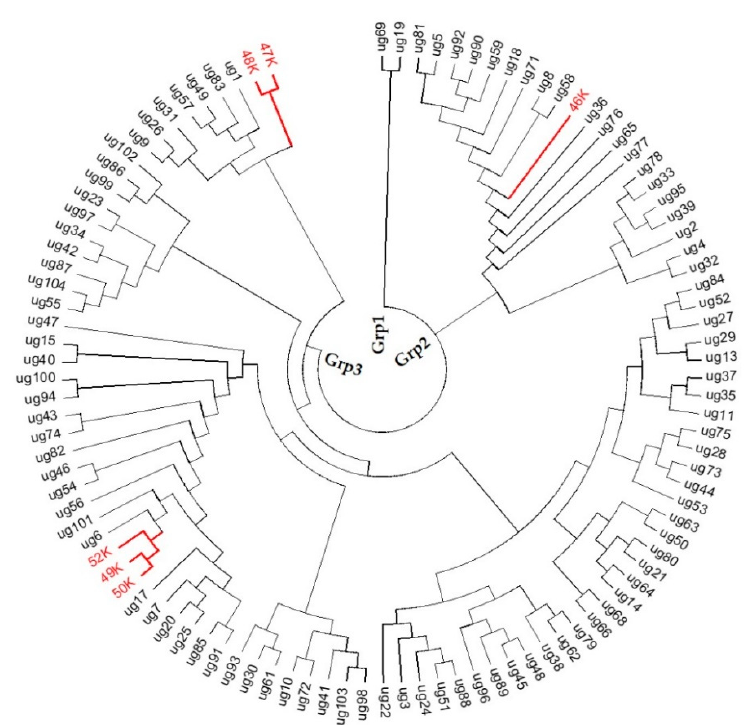
Figure 3. Neighbor-joining tree of 99 Brachiaria ecotypes from Uganda and six commercial cultivars based on Rogers’s genetic distance calculated from 24 simple sequence repeats markers. Ecotypes are denoted by initial letters ug and commercial cultivars are written in red color as 46 K ( Brachiaria humidicola cv. Humidicola), 47 K ( Brachiaria brizantha cv. MG4), 48 K ( Brachiaria brizantha cv. Piata), 49 K ( Brachiaria hybrid Mulato II), 50 K ( Brachiaria humidicola cv. Llanero), and 52 K ( Brachiaria decumbens cv. Basilisk).